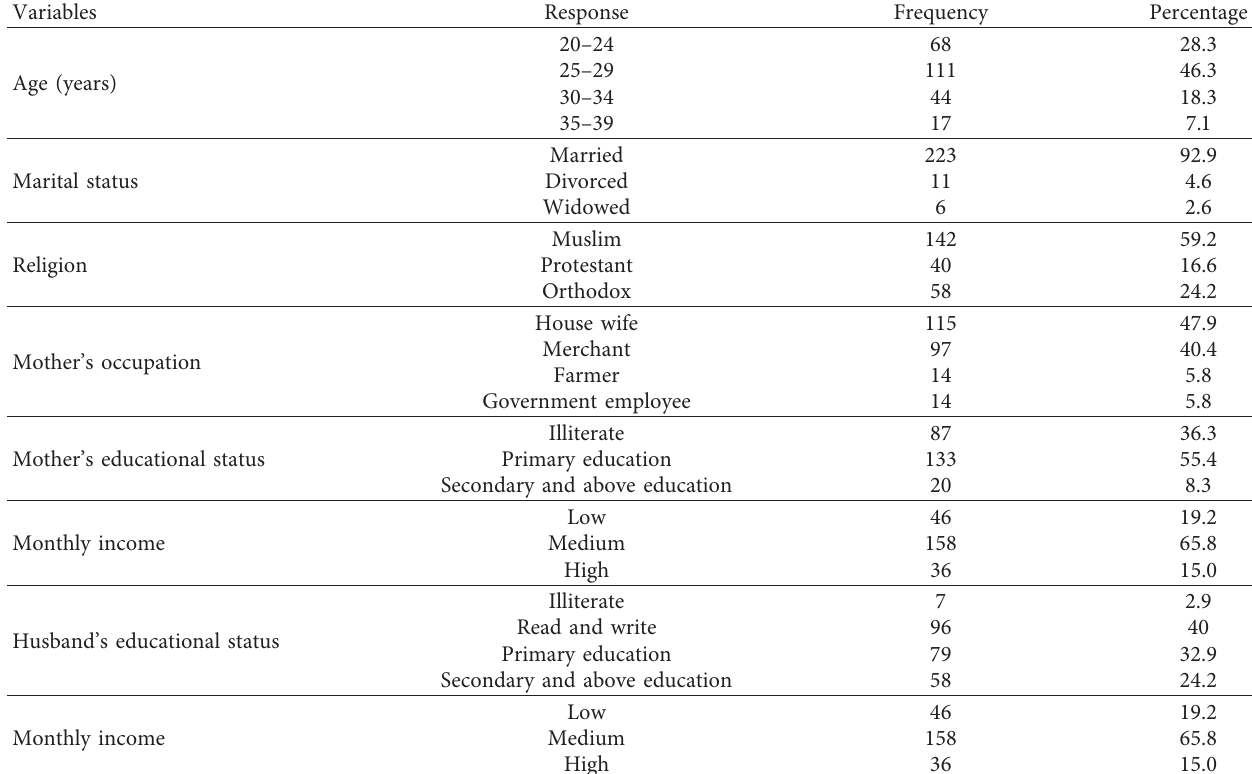
Table 1: Sociodemographic characteristics of women who gave birth in the last one year at Serbo, Kersa Woreda, Southwest Ethiopia, July 2021. Variables